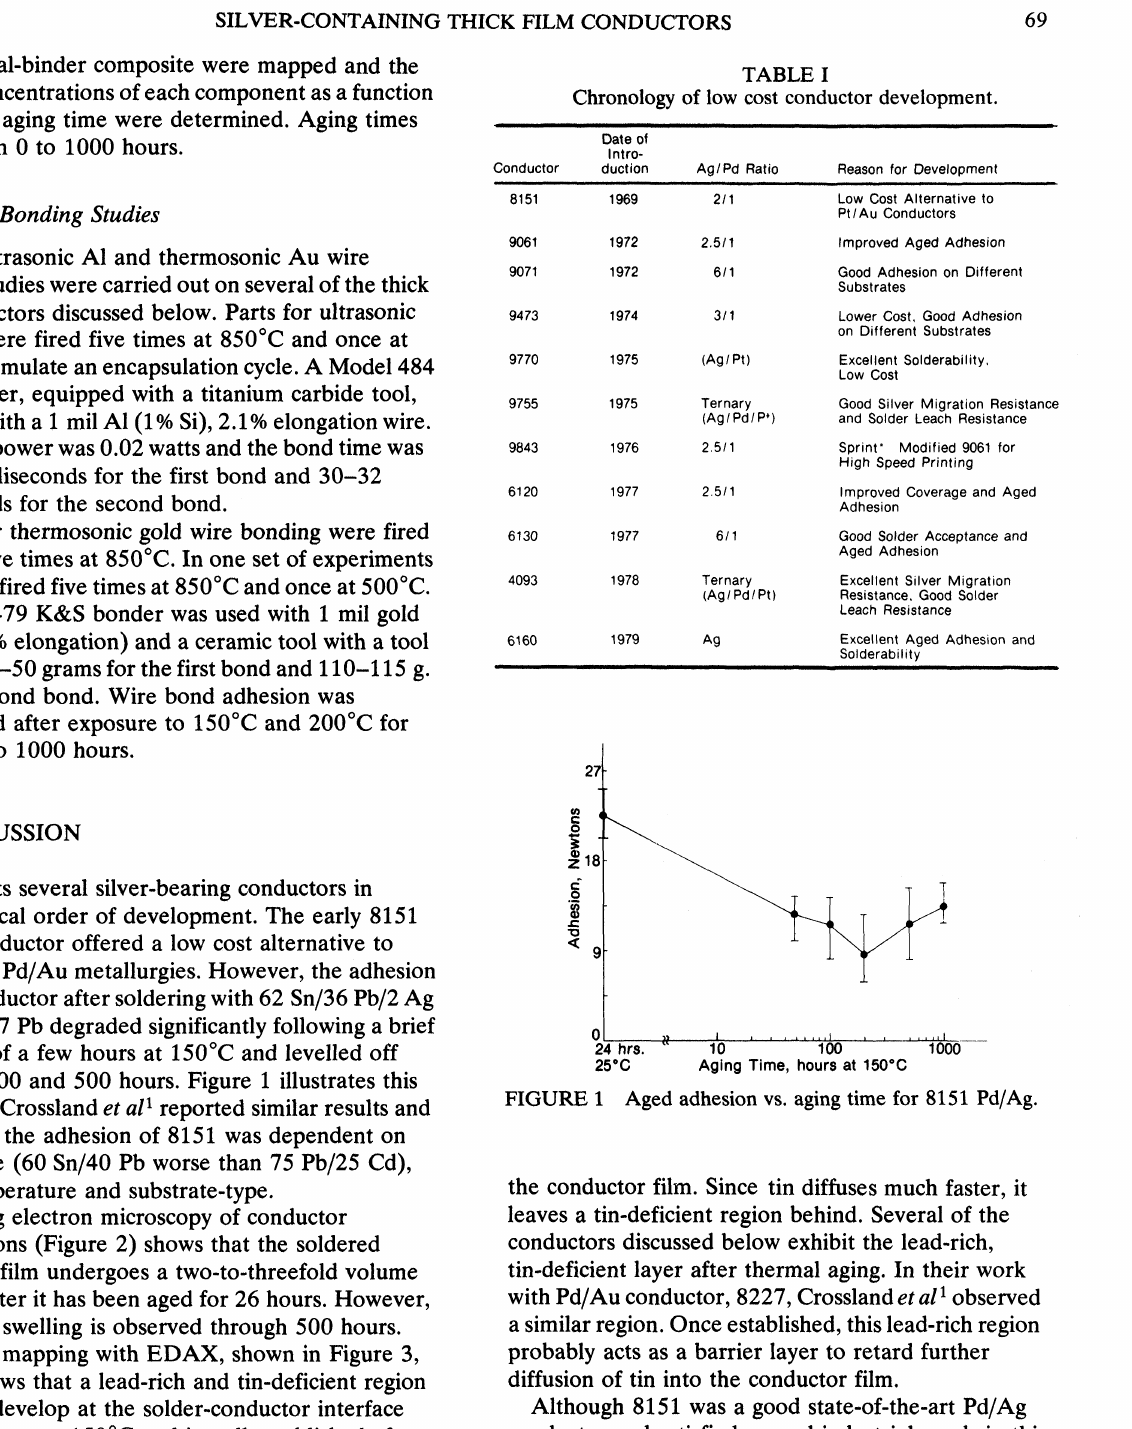
TABLE Chronology of low cost conductor development.